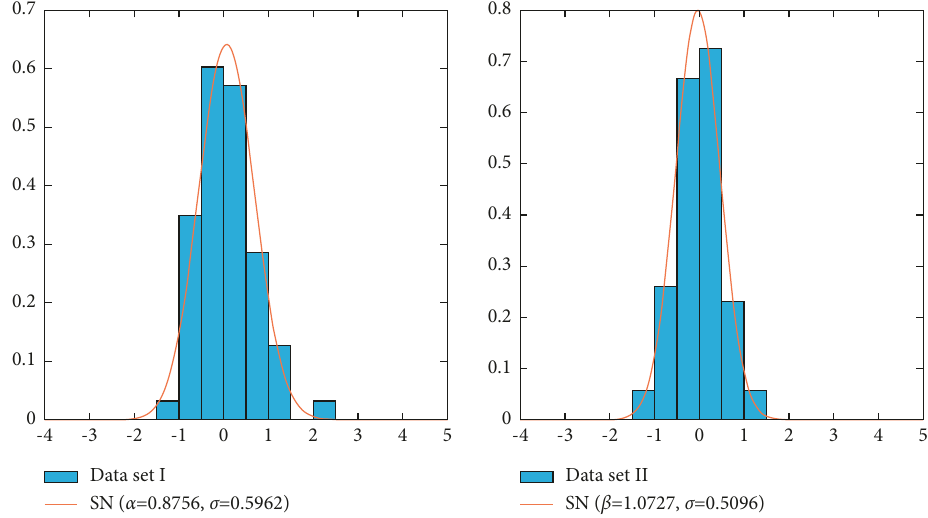
Figure 6: Fitting the SN distribution to datasets.